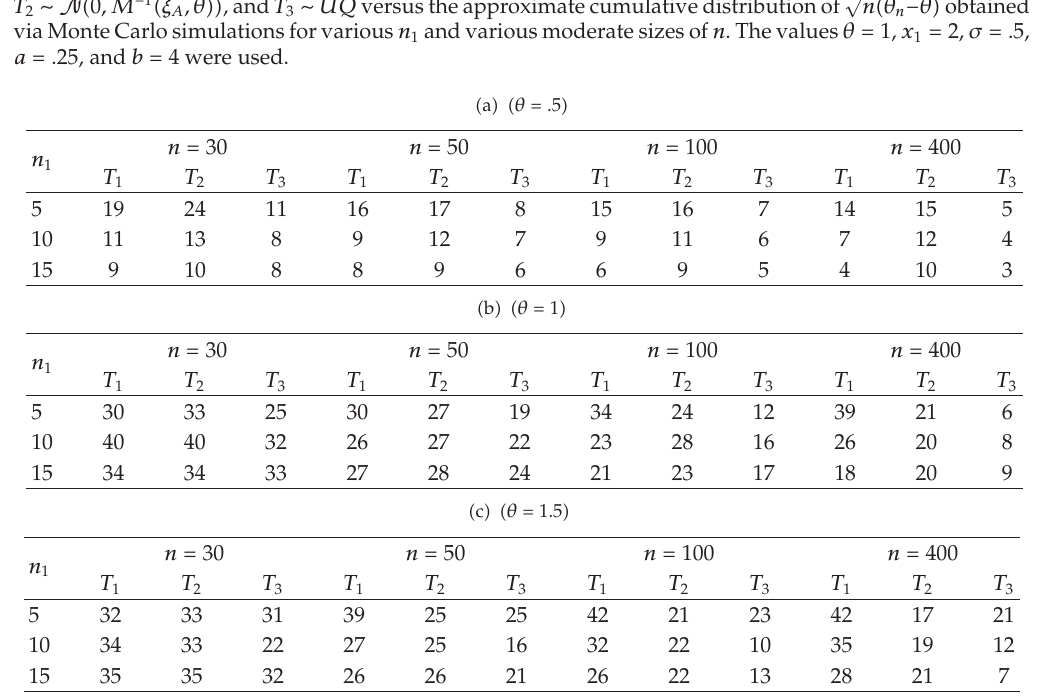
√ n (cid:7) (cid:12) θ n − θ (cid:8) obtained